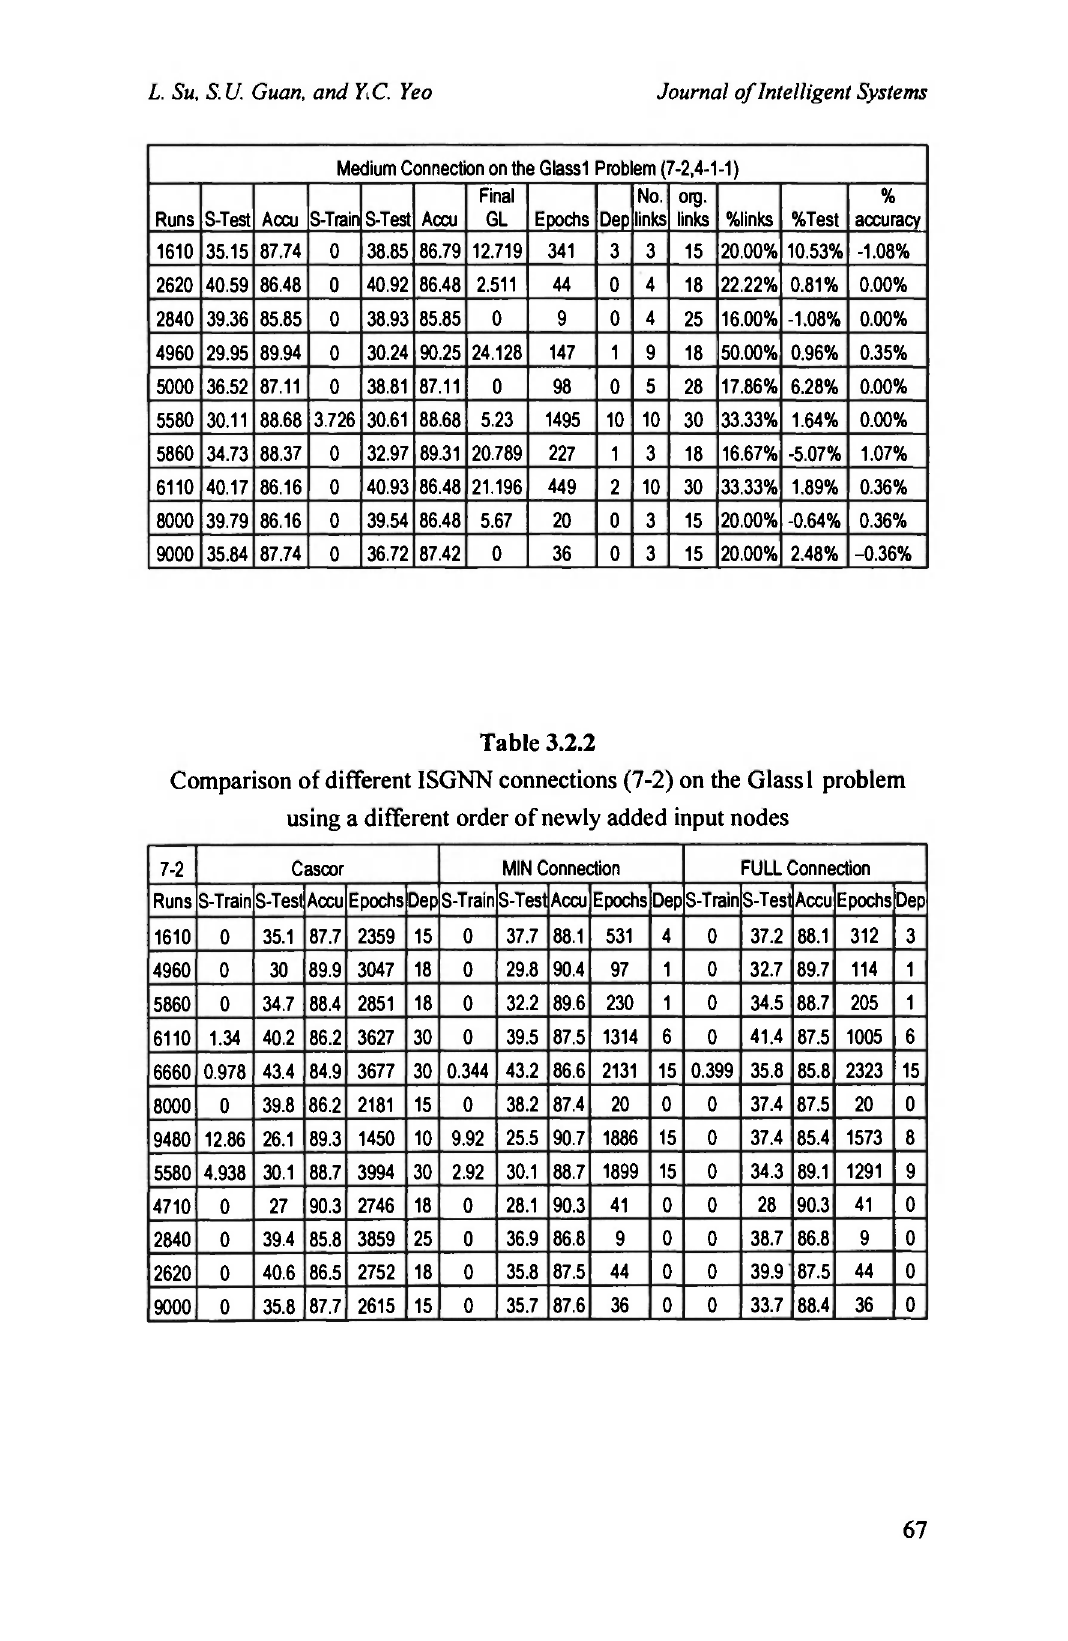
Comparison of different ISGNN connections (7-2) on the Glassl problem using a different order of newly added input nodes MIN Connection FULL